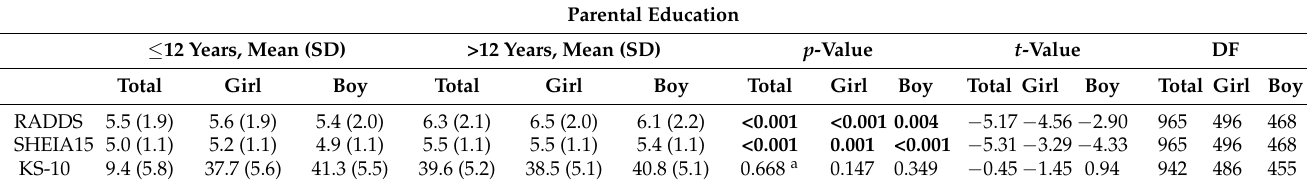
Table 4. Mean scores for RADDS, SHEIA15, and KS-10 across parental education groups. Parental